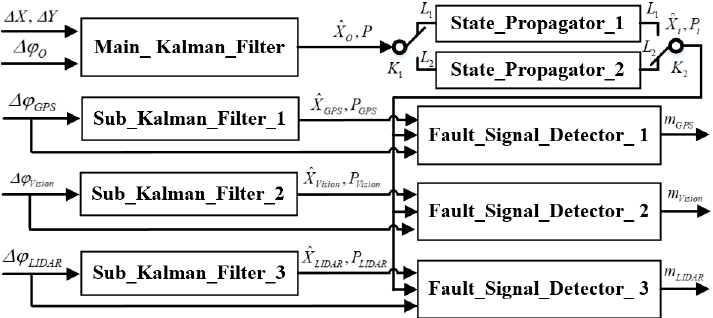
Figure 3. The block diagram of proposed faults signals detector.